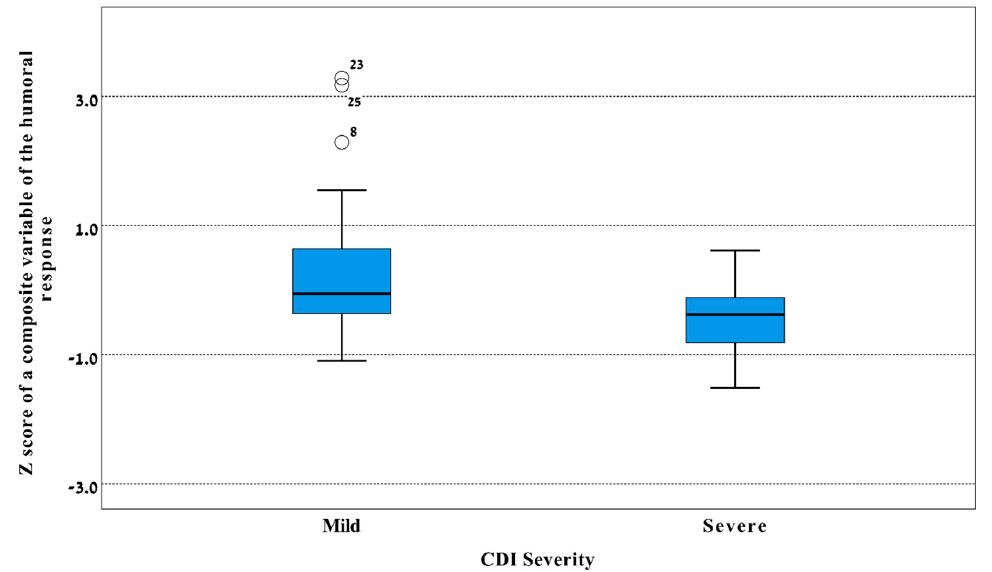
Figure 2. Box plot of Z score of the humoral immune response against Clostridium di ffi cile in patients with mild and severe CDI. A composite variable representing the humoral immune response was created using a factor analysis and it comprises serum IgG and IgA levels against toxin A and toxin B and expressed in Z scores (Y-axis). The line in the middle of the box represents the median level, lower bound of the box represents the 25th percentile, the upper bound of the box represents the 75th percentile, the lowest point of the lower whisker represents the minimum and the highest point of the upper represents the maximum. Black circles represent outliers. p = 0.026 by the Mann Whitney test for the difference between sever and mild CDI (X-axis) in the median level of this variable. CDI: Clostridium difficile infection; IgA: Immunoglobulin A; IgG: Immunoglobulin G.